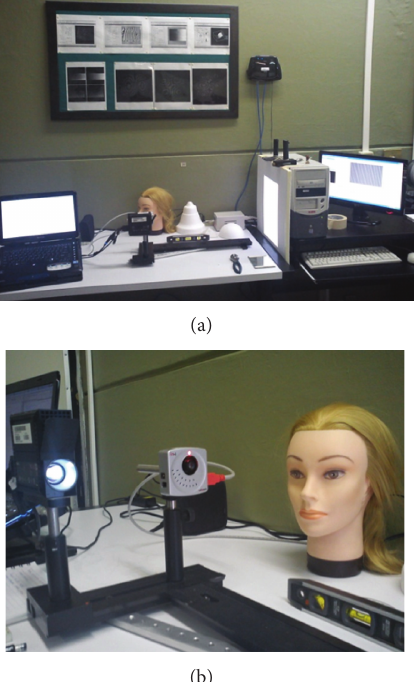
Figure 24: Equipment experimental arrangement of the three- dimensional reconstruction system.